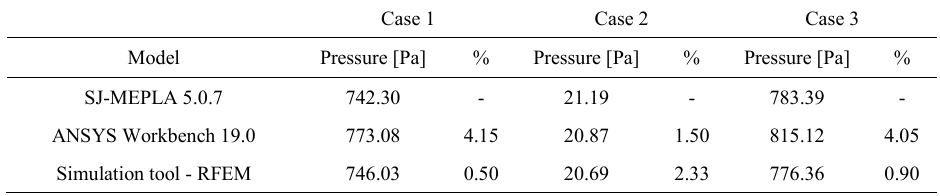
Table 1: Pressure applied on the inner pane. Flat rectangular model.